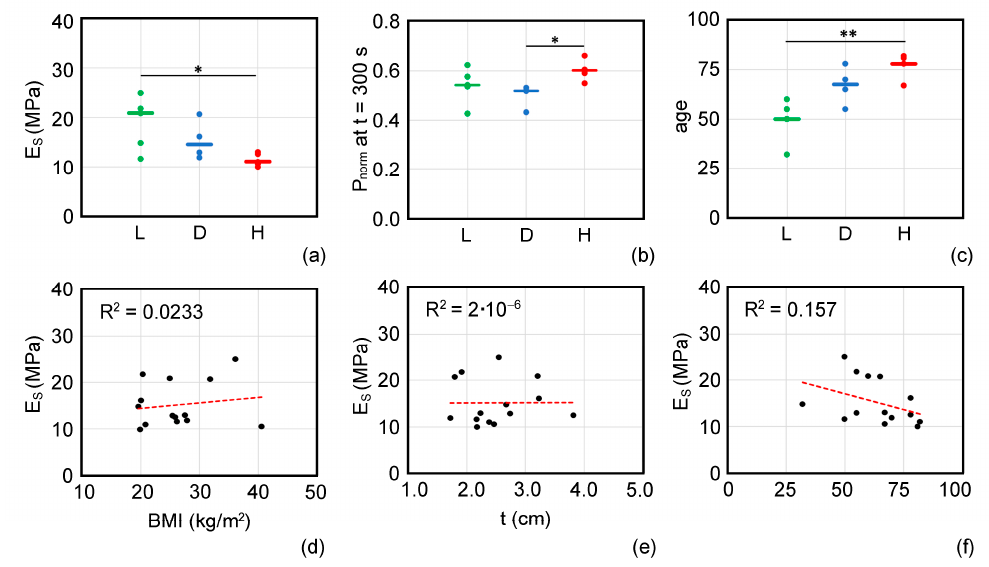
Figure 6. Comparison among PF samples from subjects with Ledderhose disease (L), diabetes (D) and healthy subjects (H): comparison of secant moduli E S ( a ); comparison of normalized stress value P norm after 300 s of stress relaxation ( b ); comparison of age ( c ); correlation between secant modulus Es and BMI ( d ); correlation between secant modulus E S and PF thickness t ( e ); correlation between secant modulus E S and age ( f ). Differences among the data are indicated as statistically significant with p -value < 0.05 (*) or p -value < 0.01